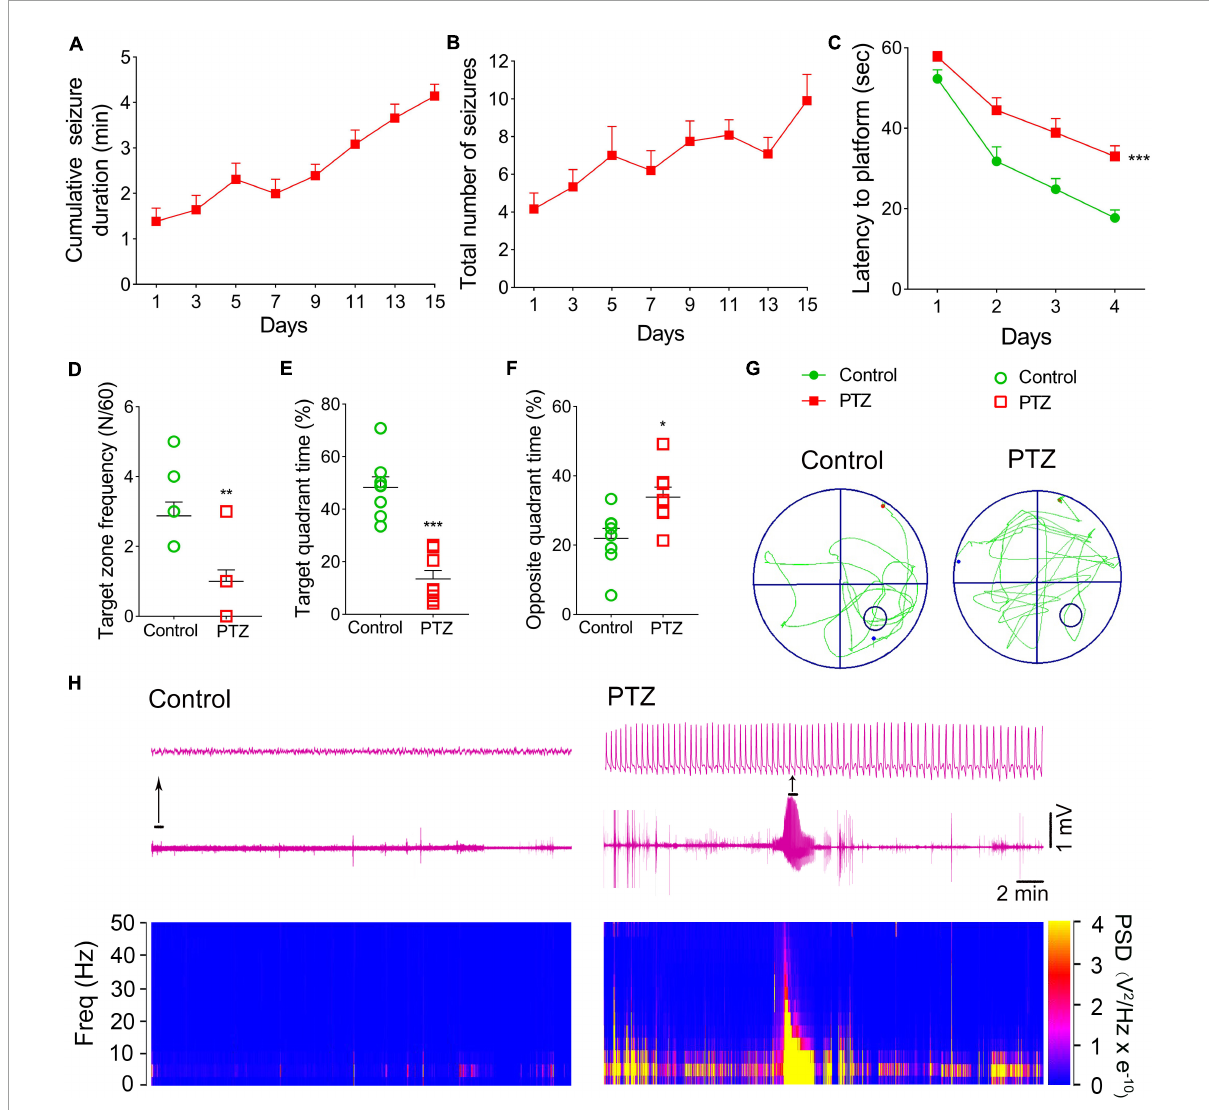
FIGURE1 Pentylenetetrazole (PTZ)-induced epileptogenesis and cognitive deficits. (A) Cumulative seizure duration. (B) Total number of seizures. (C) Latency to the platform (two-way RM-ANOVA). (D) Frequency of platform crossings. (E) Target quadrant time (%). (F) Opposite quadrant time (%). (G) Representative platform exploration trajectories. (H) Representative EEGs and power spectrum density. Data are presented as mean ± SEM. * P < 0.05, ** P < 0.01, and *** P < 0.001, compared with controls (unpaired T